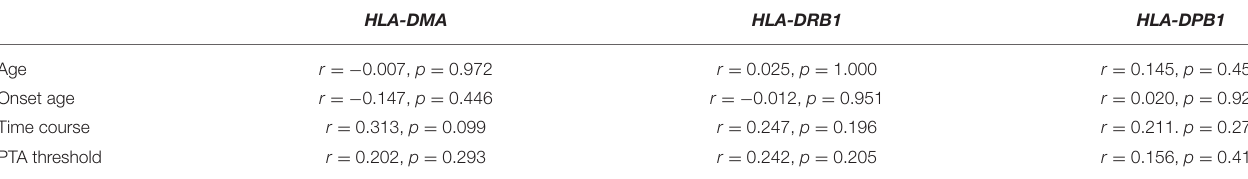
TABLE 4 | The correlation analysis between gene expression levels and clinical characteristics.